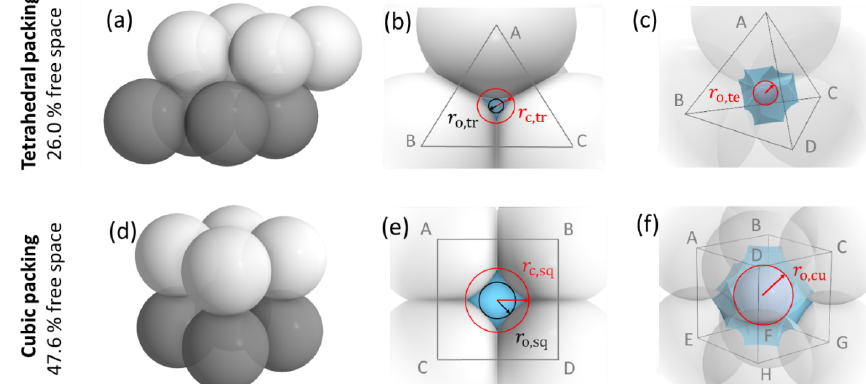
Figure 2. Overview of tetrahedral (a) and cubic (d) packing arrangements along with theoretical porosities when ordering uniformly sized spheres into a cubic unit cell, defined as the volume of the voids relative to the total volume of the sample unit cell. The porosity refers to zero overlap between rigid spheres and is independent of sphere size. Differently coloured spheres indicate spheres in different lattice planes of the arrangements. Panels (b) and (e) present an enlargement of the three-membered and four-membered ring pores along with key pore dimensions relevant for PCF as discussed in the text. Panels (c) and (f) reveal the inner cavities forming a concave octahedron (tetrahedral packing) and concave cube (cubic packing). See Figs. A1 and A2 for a more detailed view of panels (c) and (f)